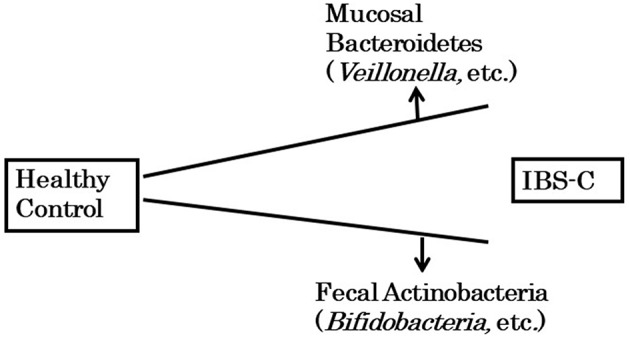
Dysbiosis in IBS-C patient.